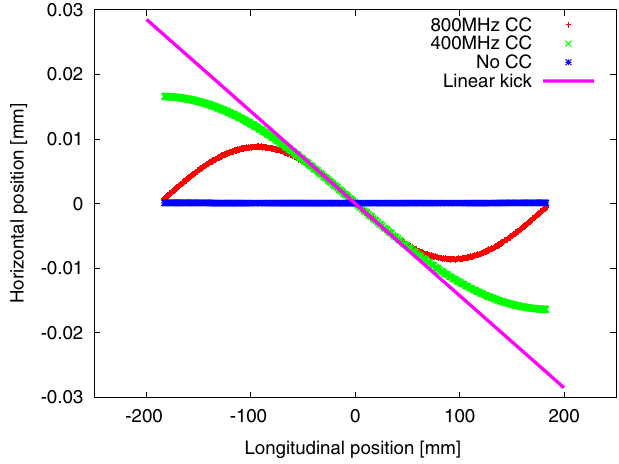
FIG. 5. (Color) Turn-by-turn x - z correlation of an off- momentum particle ( 2 : 5 (cid:3) p ) at IP5 with 400-MHz and 800- MHz global crab cavity, for the nominal LHC optics (with rms bunch length (cid:3) z ¼ 75 : 5 mm ). The crab-cavity kick is linear within 1 (cid:3) z , which recovers most of the geometric luminosity expected without crossing